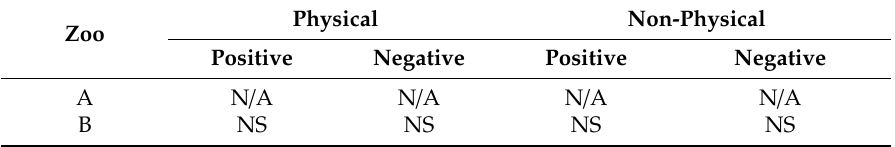
Table 6. Mantel test correlation scores showing dyadic reciprocity in the study